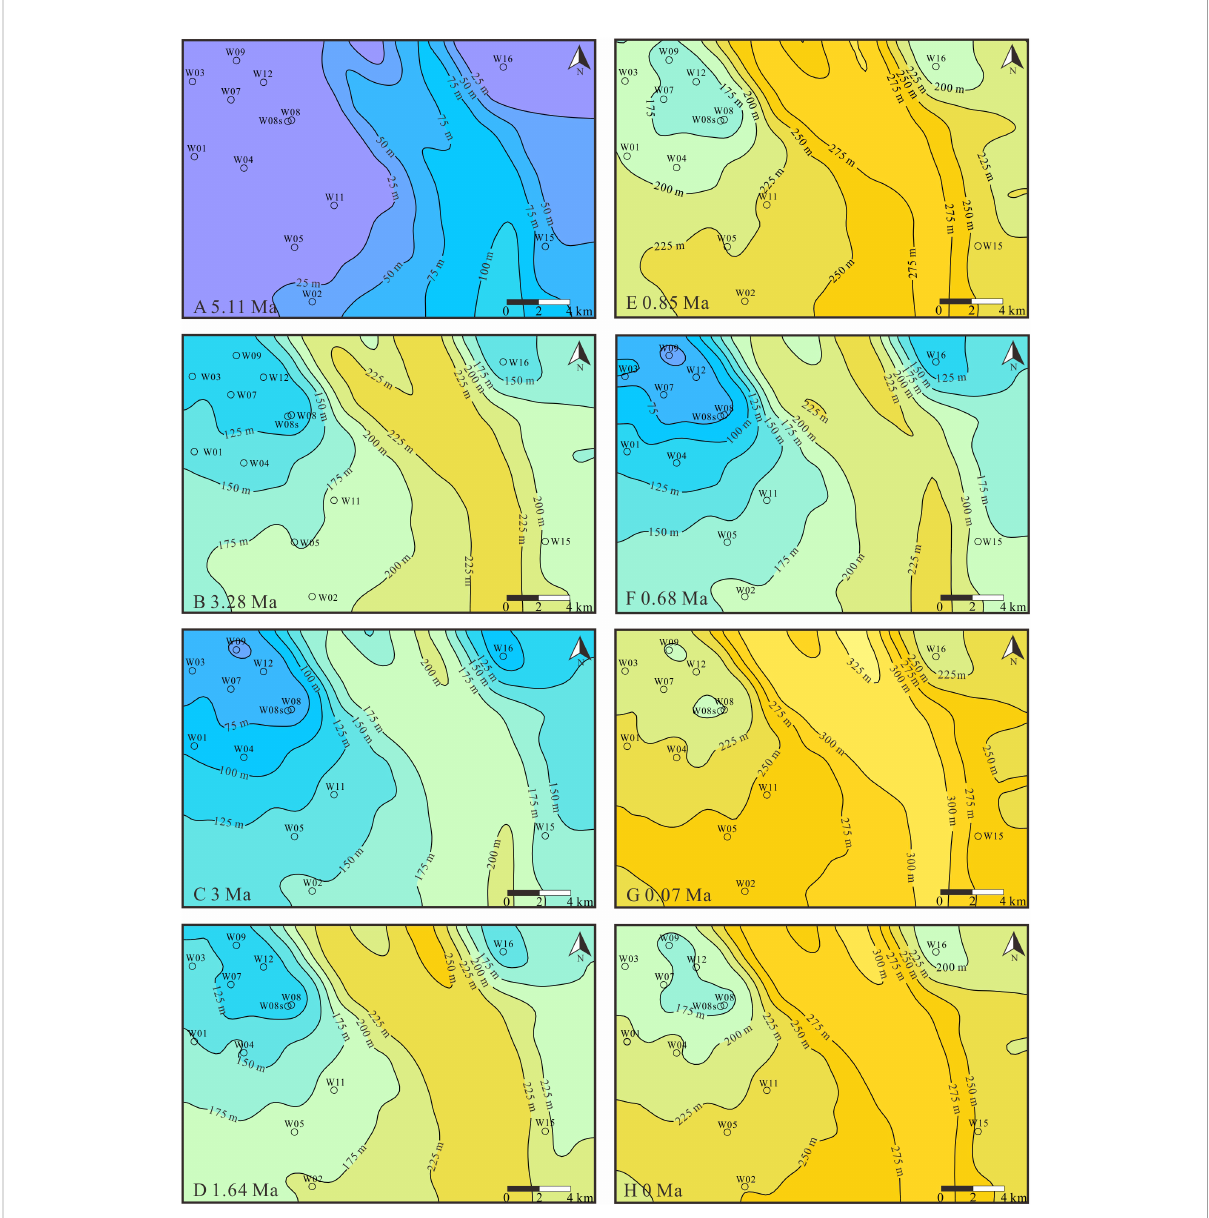
FIGURE 7 Characteristics of the GHSZ in the Dongsha region. (A) 5.11 Ma, (B) 3.28 Ma, (C) 3 Ma, (D) 1.64 Ma, (E) 0.85 Ma, (F) 0.68 Ma, (G) 0.07 Ma, (H) 0